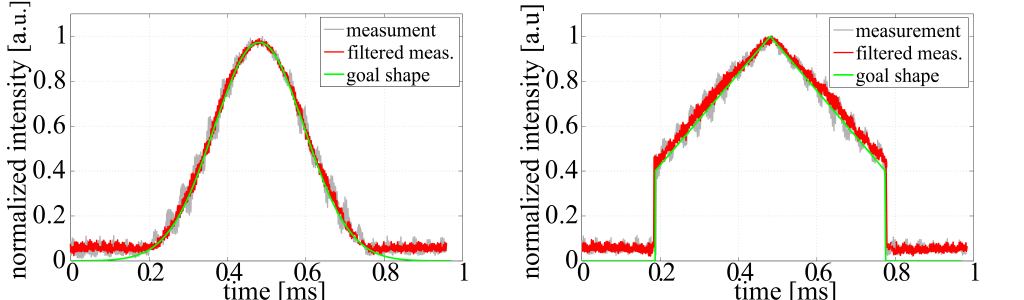
Figure 3. ( Left ) Gaussian-shaped burst envelope; ( right ) house-shaped burst